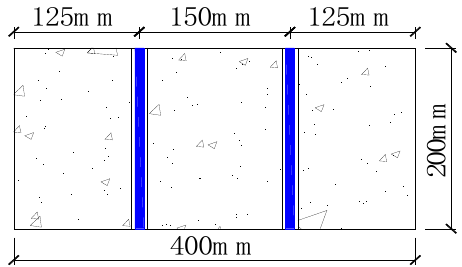
Figure 3. Details of test specimens in cross section.